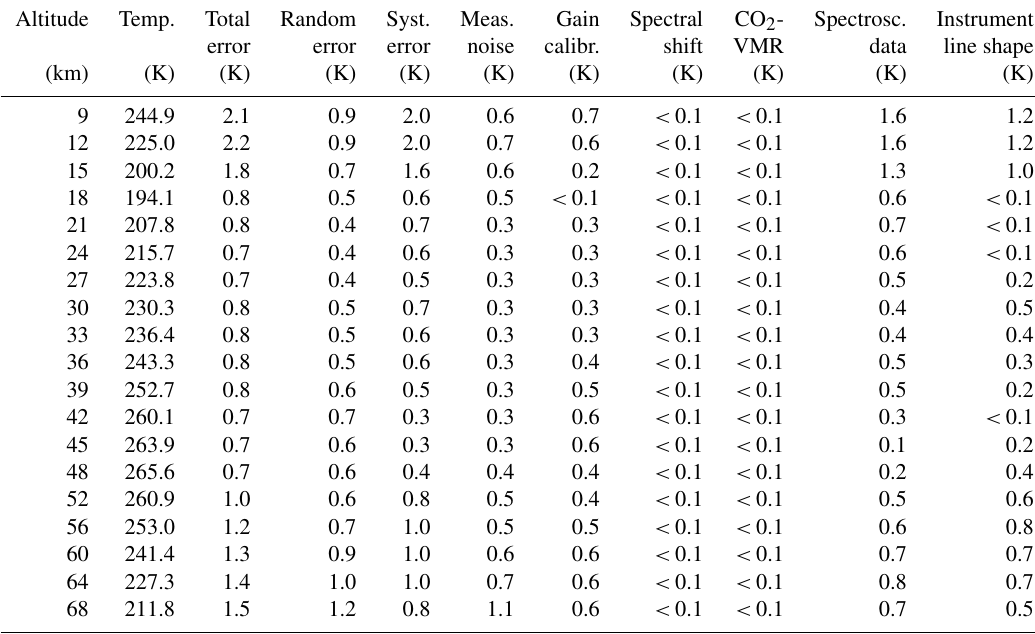
Table A7. RR data temperature error budget for tropical day. All uncertainties are 1 σ . Altitude Temp.